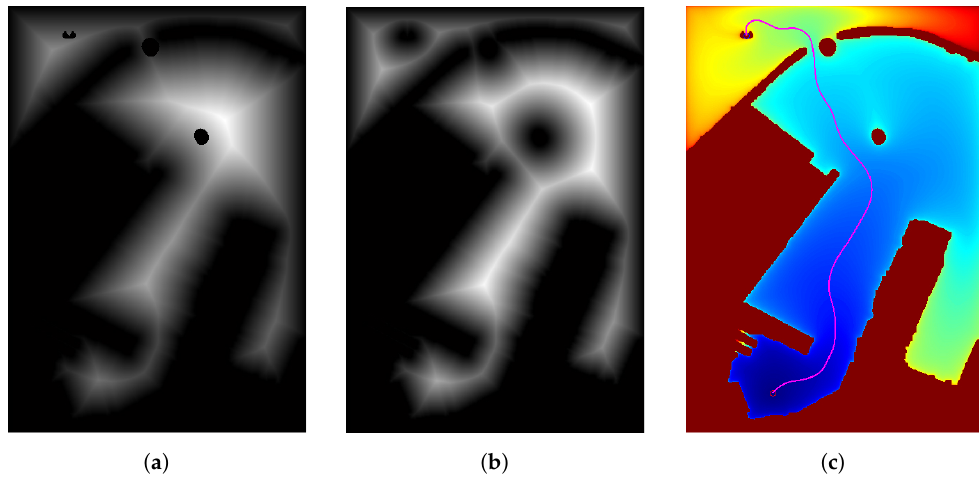
Figure 16. Path re-planning in an actual environment. ( a ) Addition of domain models to potential map V (time 0.30 s); ( b ) New potential map V (cid:48) by tunable fast marching square (TFMS; time 1.80 s); ( c ) Generated path and arrival time matrix T (time 1.80